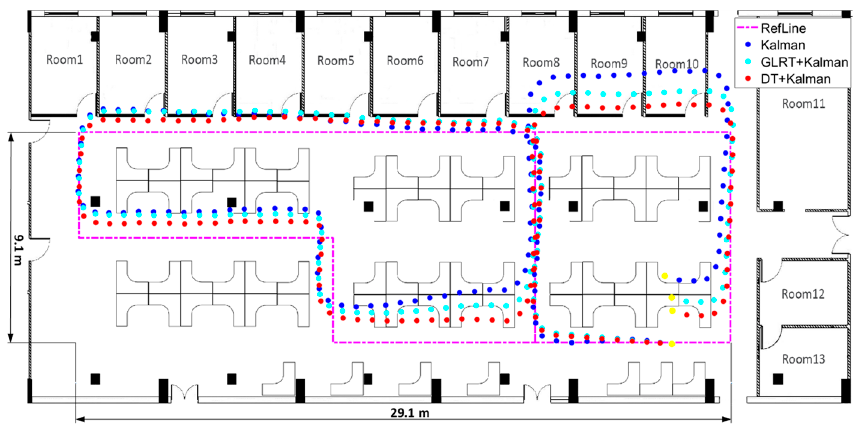
Figure 18. The result of the trajectory test based on the three algorithms in indoor pedestrian inertial navigation. The walking time is 128.3 s indoors.